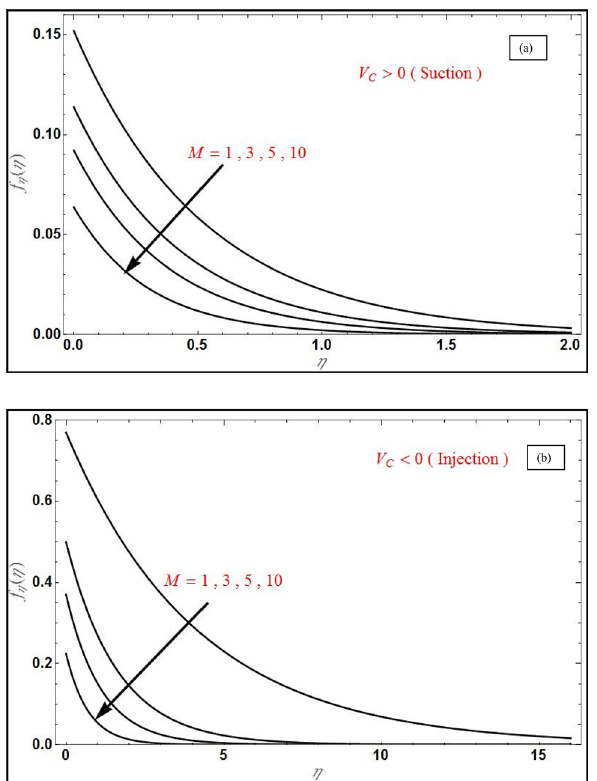
Figure 3. Axial velocity profile f η (η) for varying magnetic parameter ( M ) for ( a ) suction ( V C = 1 ) and ( b ) injection ( V C = − 1 ) with Da − 1 = (cid:31) = 1 , S 1 = 1, S 2 = − 1 , ϕ 1 = 0.1, ϕ 2 = 0.04